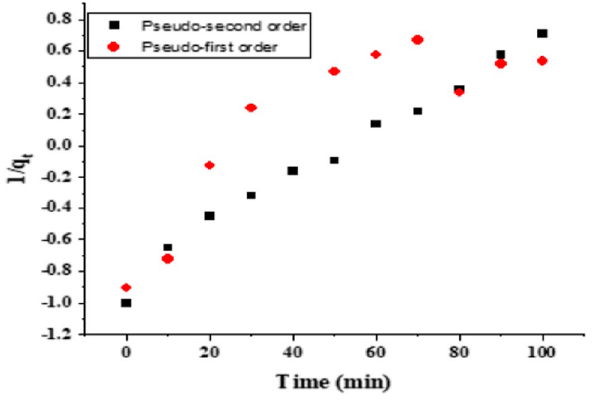
Fig. 6 Pseudo-first and pseudo-second-order plot for MO adsorption onto Anchote peel (70 mg/L, pH: 8, adsorbent dose: 0.4 g, contact time: 140 min, shaking speed 120 rpm, and temperature: 25 °C)